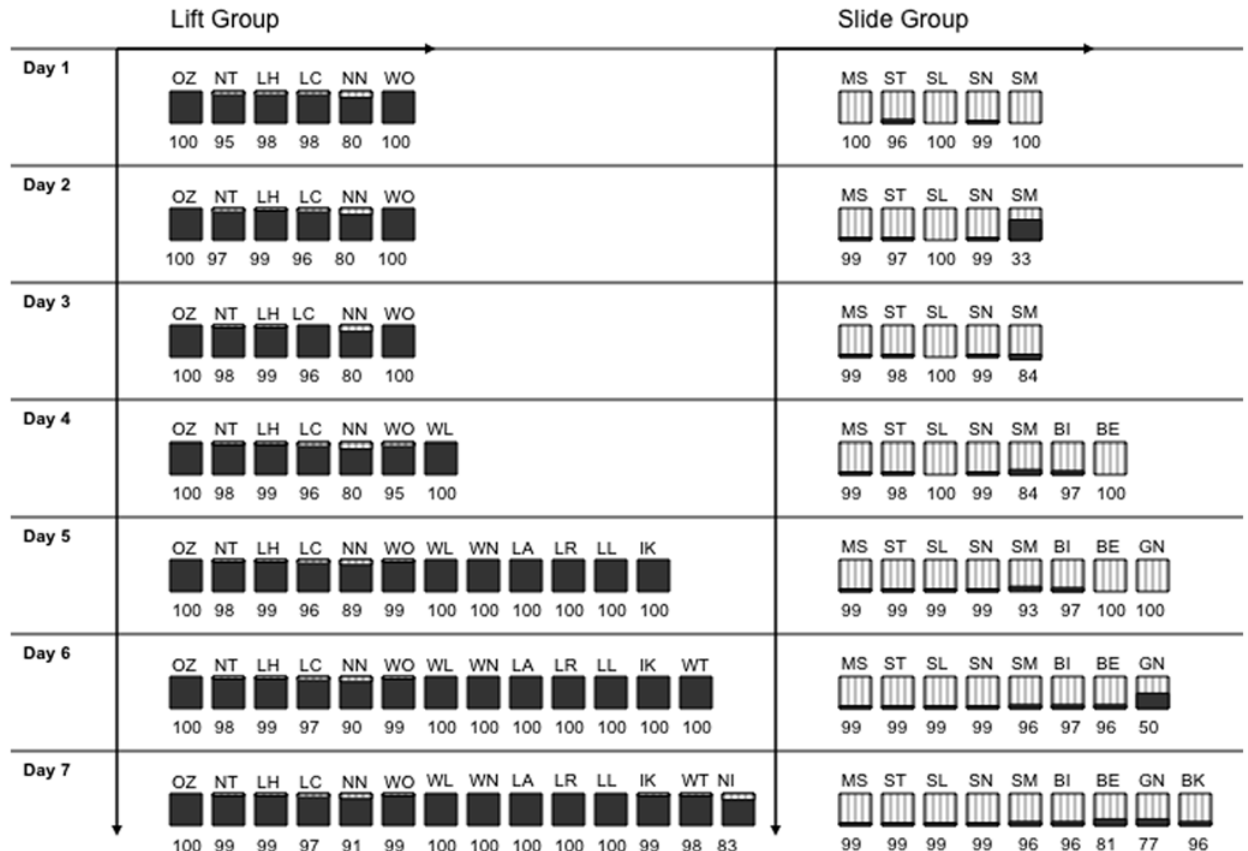
Figure 3. Group diffusion chart. Each square represents a subject, with the subject’s code above and cumulative percent fidelity below. Subjects enter the chart on successful gaining of food fro the Doorian. Gray indicates the lift method and striped indicates slide. Left to right arrows indicate the order of acquisition beginning with the models (OZ and MS), and top to bottom arrows indicate the progression of days. The first letter of each code indicates to which matriline an individual belongs, and therefore also indicates relatedness. Note that NT, LH, LC, and WO were absent on day 7, thus there scores represent at total of 6 day.